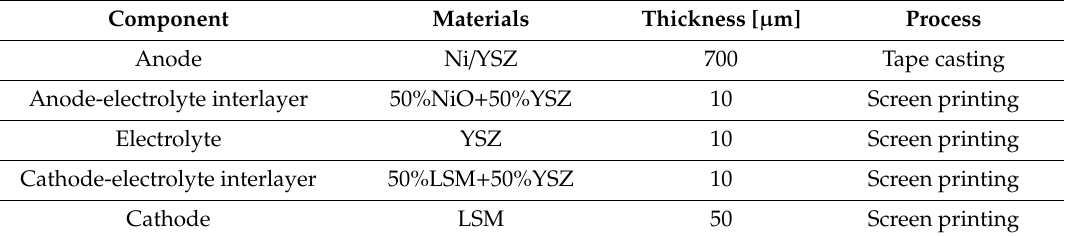
Table 3. Characteristics and manufacturing processes of EEA